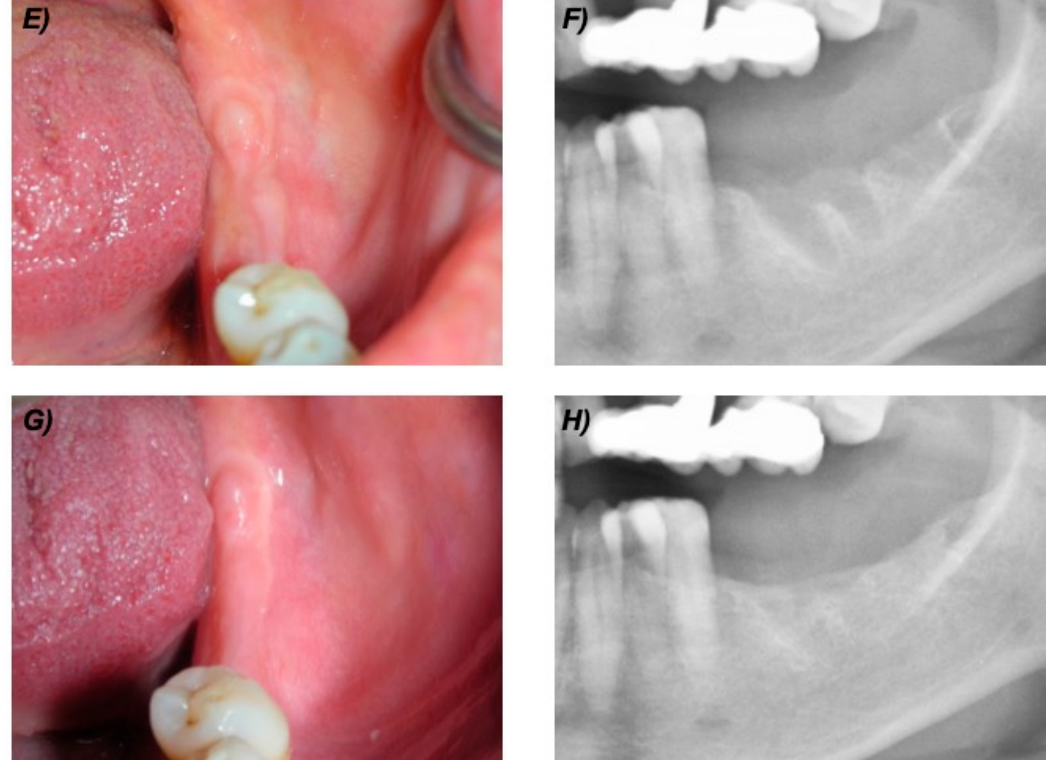
Figure 2. Clinical and radiological follow up of the same patient of Figure 1. ( E ) Clinical view at 6 months. ( F ) Detail of the panoramic X-ray at 6 months. ( G ) Clinical view at 24 months. ( H ) Detail of the panoramic X-ray at 24 months. Table 3. Descriptive details of patients enrolled (n = 20; ONC = 6; OST = 14).